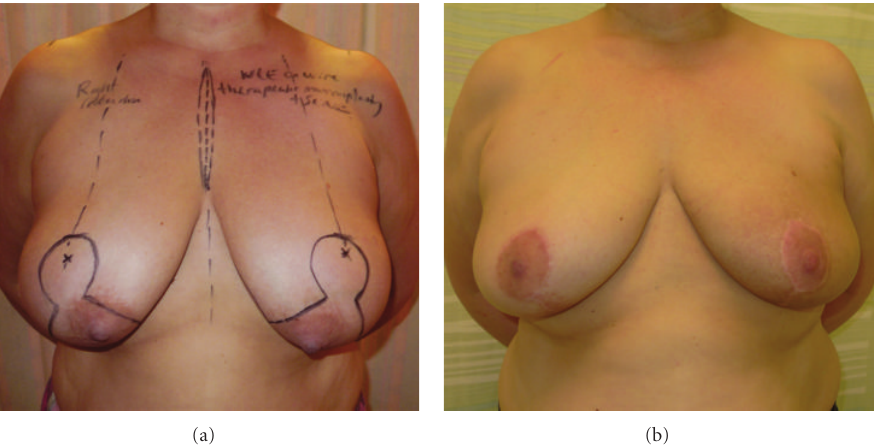
Figure 6: (a) This 51-year-old patient with large, ptotic breasts and nipple-areola complexes situated medial to the breast meridian presented with a left breast cancer. These images show the skin markings used to plan a therapeutic inverted-T mammoplasty and simultaneous contralateral reduction mammoplasty for symmetrisation. (b) Adjuvant radiotherapy to the left breast has resulted in mild changes in skin pigmentation but symmetry is still good with the contralateral breast being still